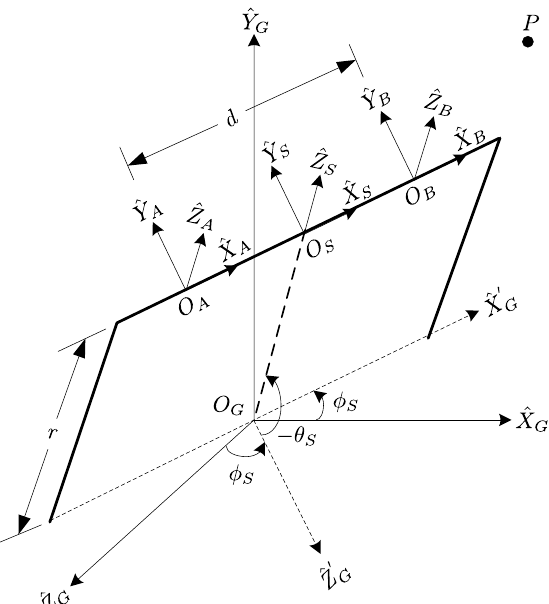
Figure 4. Coordinate